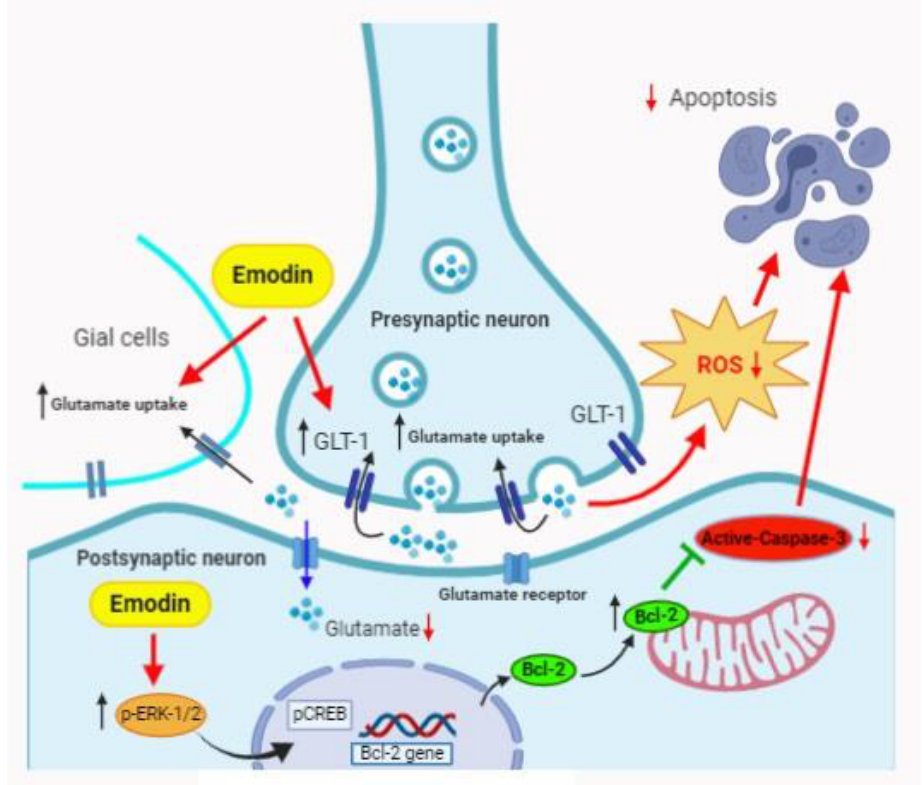
Figure 5. The proposed mechanisms of Emodin on the protection effect in a rat MCAO model: Emodin prevents glutamate release through GLT-1 and decreases ROS production, resulting in suppression of apoptosis. Additionally, Emodin stimulates p-ERK1 / 2 expression and blocks caspase-3 to decrease apoptosis via the regulation of Bcl-2 gene.